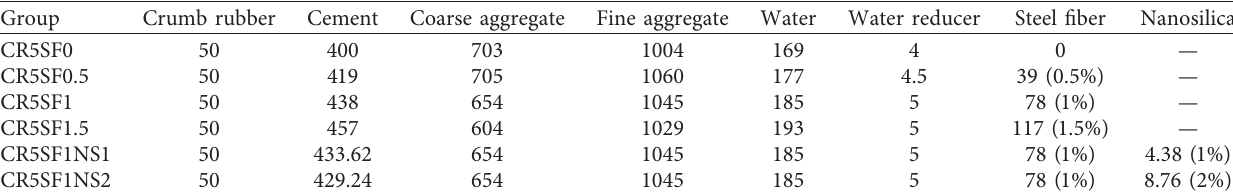
Figure 3: (a) Materials. (b) Concrete slump test. Table 4: Mix proportions of SFNS-CRC (unit: kg/m 3